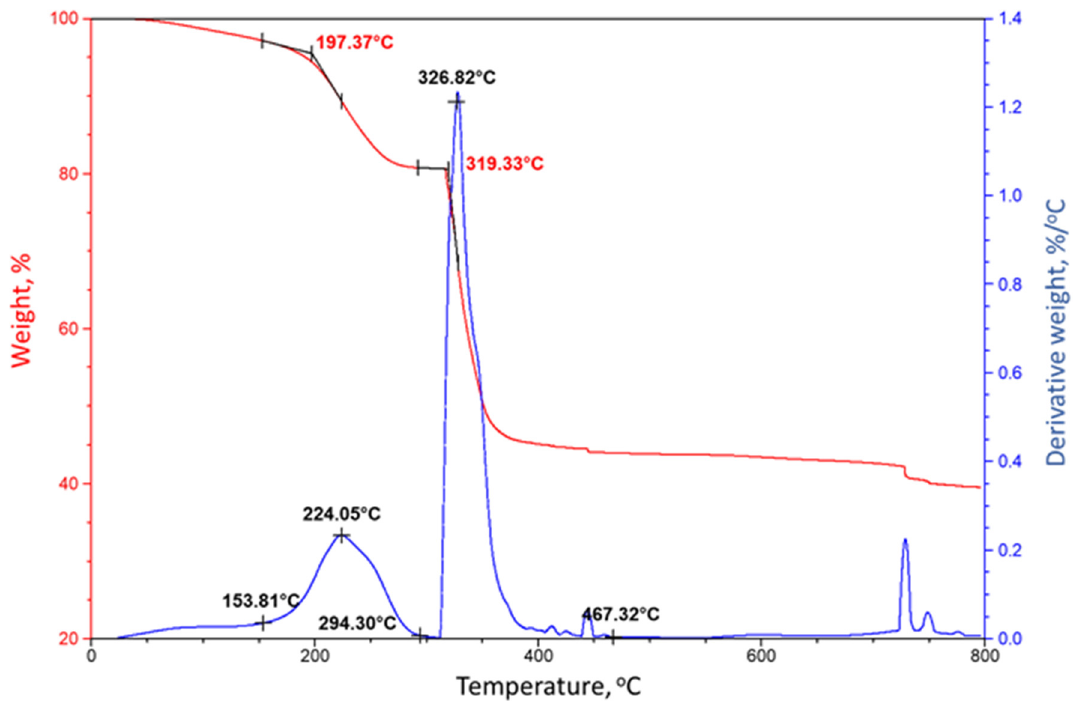
Figure 9. TGA and DTG curves for “as-received” PMHS liquid.